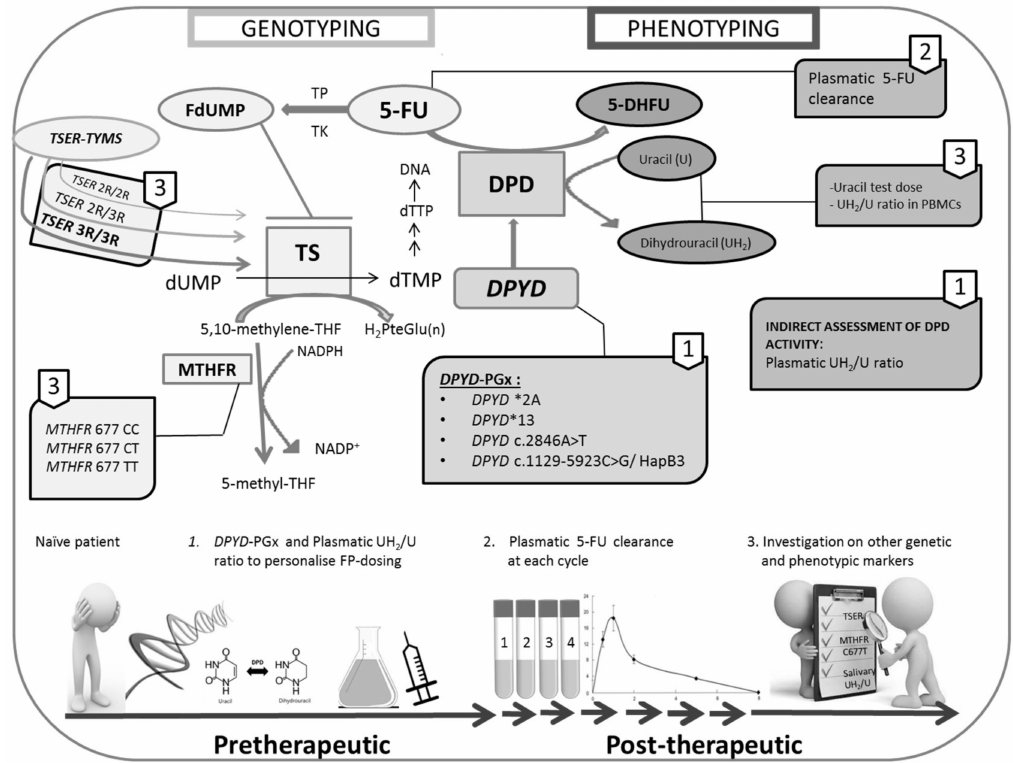
Figure 2. This figure illustrates the main enzymatic reactions involved in the fluoropyrimidines (FP)